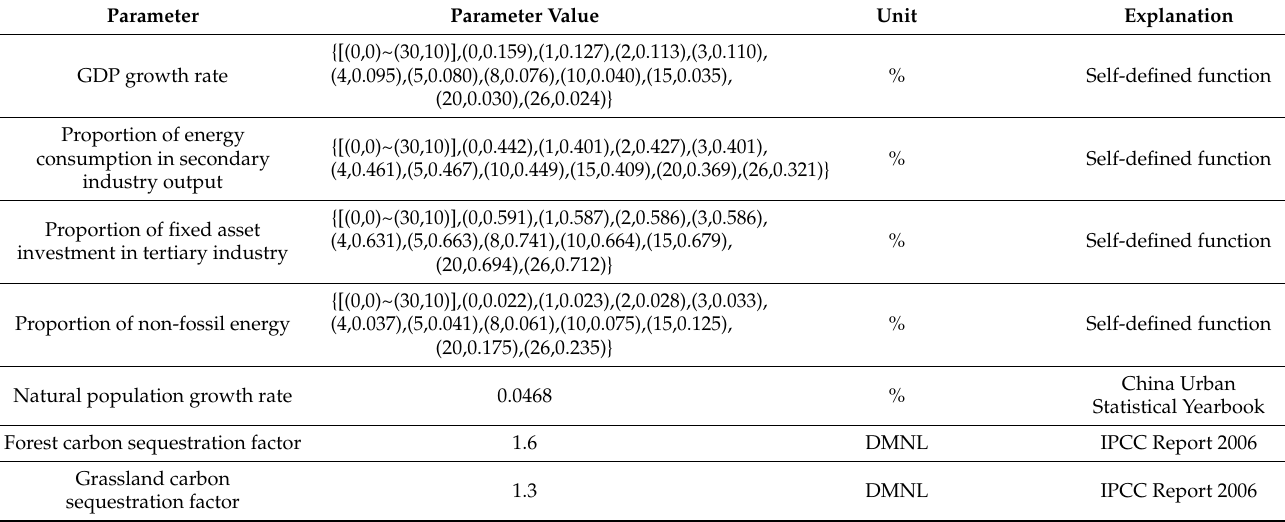
Table 4. Important parameters and their